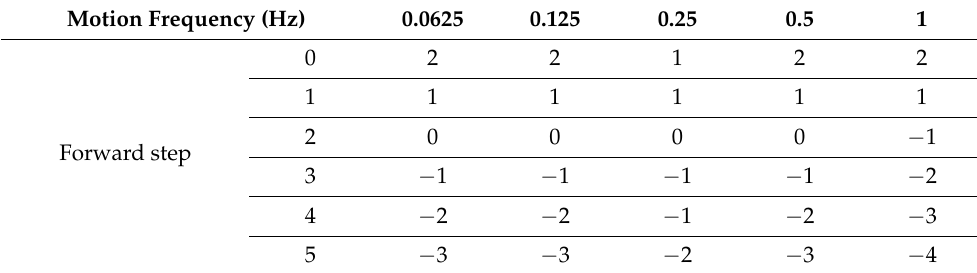
Table 3. Phase deviation with different numbers of prediction steps ( ω s = 10 Hz).